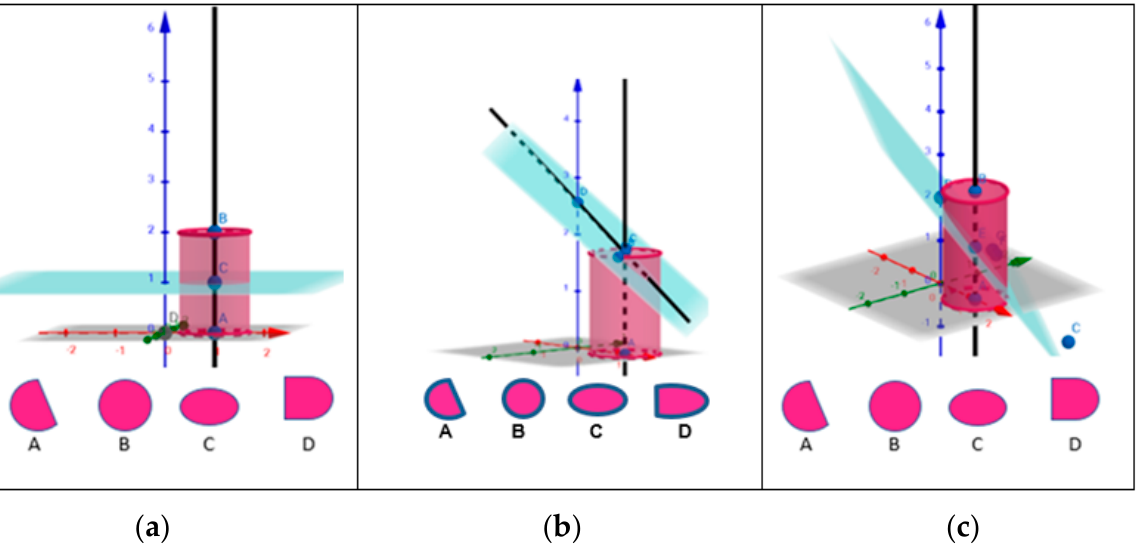
Figure 10. ( a ) Low level Santa Barbara Solids Test; ( b ) medium level Santa Barbara Solids Test; ( c ) complex level Santa Barbara Solids Test.